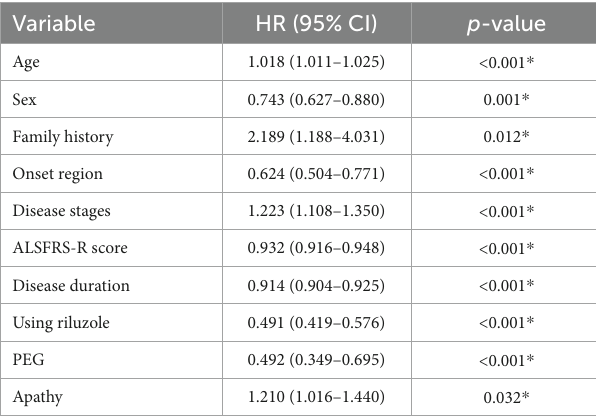
TABLE 5 Multivariate Cox analyses of factors associated with survival in ALS patients.